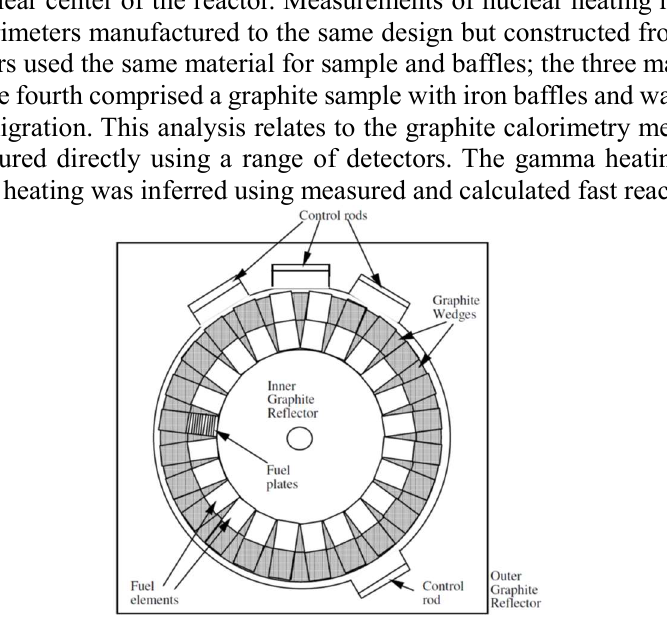
Figure 2. Plan View of the NESSUS Facility in the NESTOR